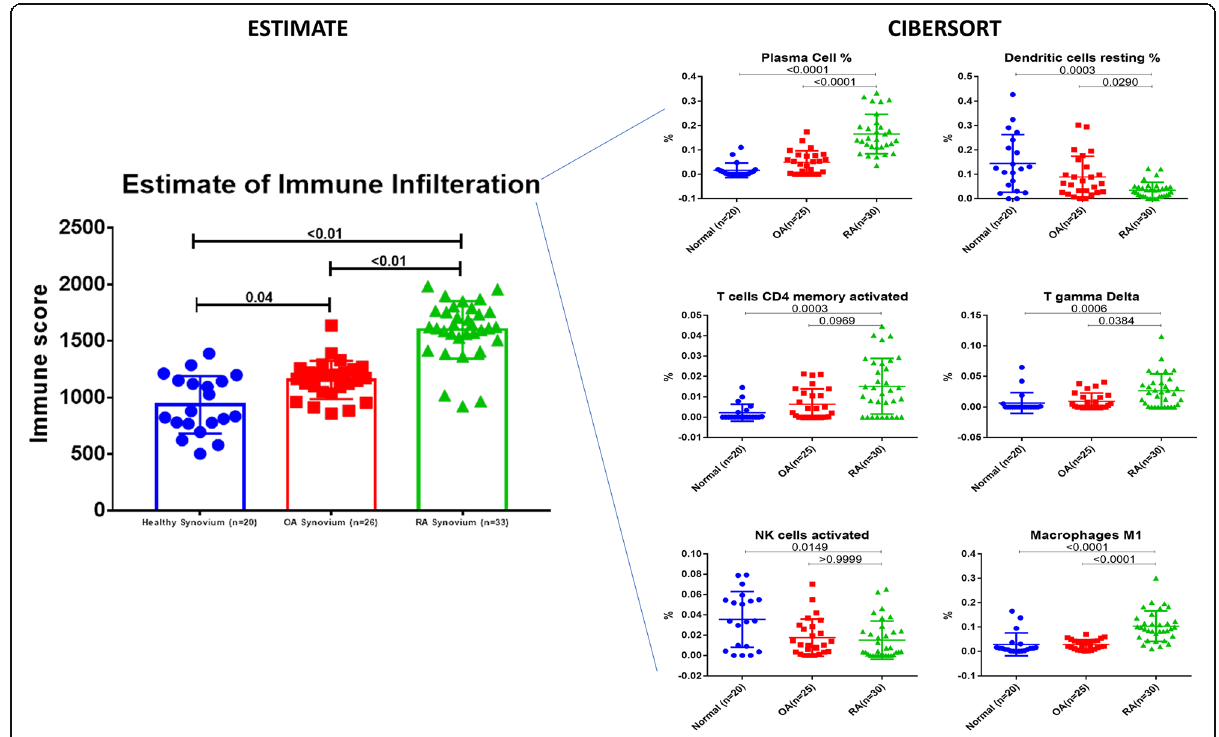
Fig. 2 Estimating immune cells infiltration in the synovium using transcriptomics profile of rheumatoid arthritis (RA) patients versus healthy controls (N) and osteoarthritis (OA). We used the ESTIMATE tool to estimate the difference in the infiltration of immune cells in healthy, OA, and RA synovium using their transcriptomic profile. The raw RNAseq data were used for in silico prediction of the immune cells ’ infiltration of the synovial tissue using CIBERSORT analytical tool to evaluate changes in the immune population and/or activation status between the